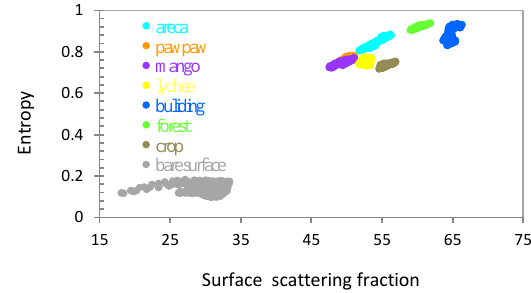
Figure.3.Entropy–Surface fraction scatter plot of different types of